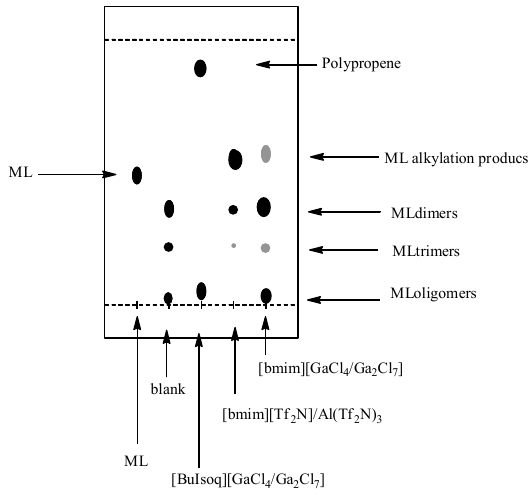
Figure 3. TLC analysis of the reactions between methyl linoleate and propene in [BuIsoq][GaCl 4 /Ga 2 Cl 7 ], [bmim][Tf 2 N]/Al(Tf 2 N) 3, and [bmim][GaCl 4 /Ga 2 Cl 7 ]. ML: pure methyl linoleate; Blank: experiment carried out in [bmim][GaCl 4 /Ga 2 Cl 7 ] without propene.